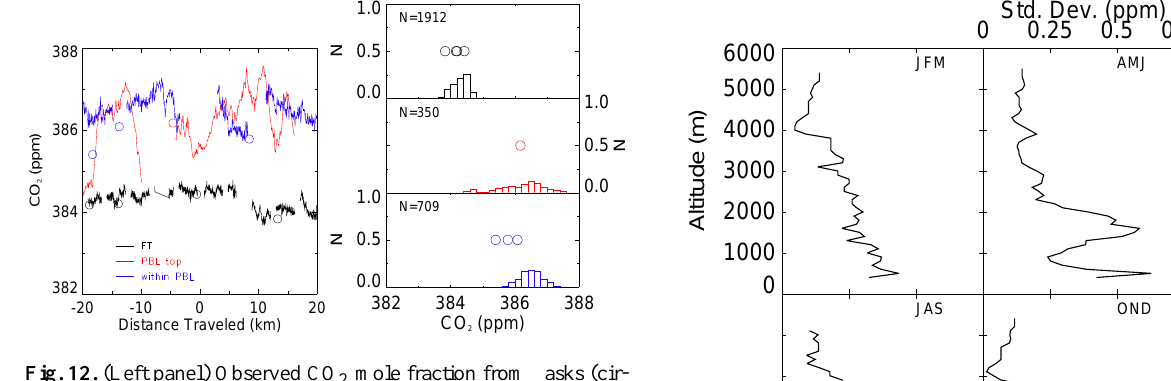
Fig. 12. (Left panel) Observed CO 2 mole fraction from flasks (cir- cles) and RM0 across horizontal legs in the FT (black), at the PBL top (red), and within the PBL (blue), for the 4 August 2008 flight. The FT line includes observations from three horizontal legs be- tween 2500m and 3200ma.m.s.l.; the PBL top line includes obser- vations from one horizontal leg at ∼ 1000ma.m.s.l.; and the within PBL line includes observations from two horizontal legs between 500m and 600ma.m.s.l. The PBL legs were 5min and are scaled to fit the same distance axis. (Right panel) The same data as in the left panel, plotted as probability distribution functions for FT, PBL top, and within PBL CO 2 mole fraction. Data were non-normally distributed in the FT and at the PBL top; these types of non-normal distributions were common throughout the five years in all three al- titude regimes. There was an offset, or bias, between the flask values and the mean value of the continuous data in the PBL but not in the FT.